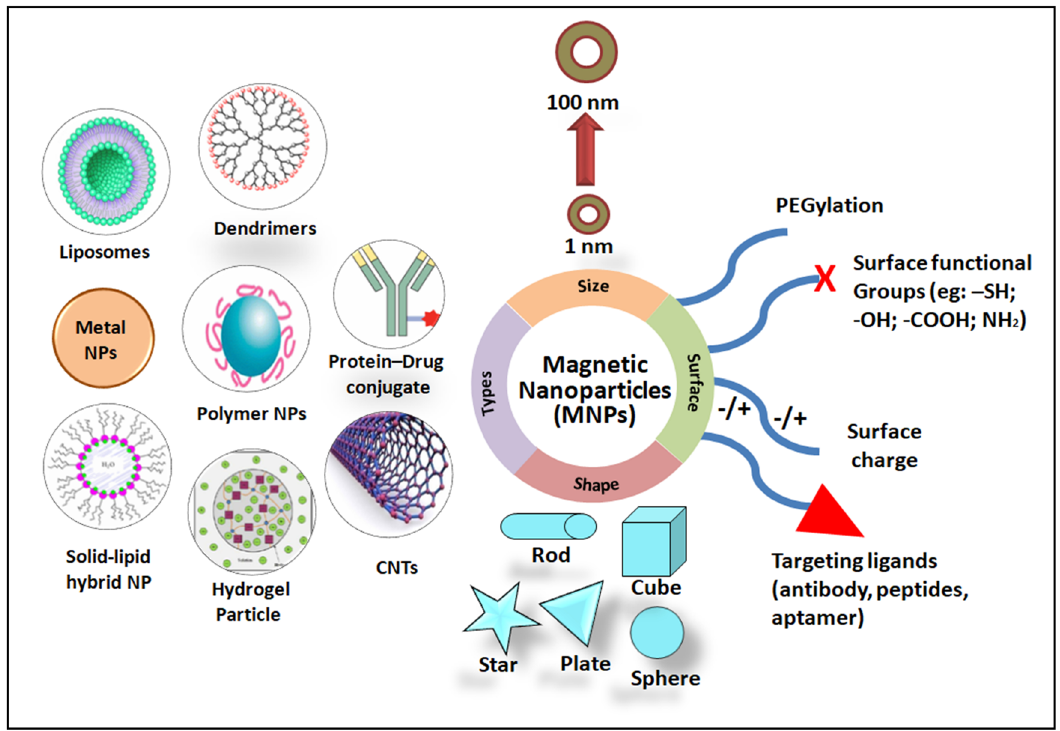
Figure 2: Classi fi cation of MNPs employed as carriers for drug delivery in cancer therapy [ 8 ]